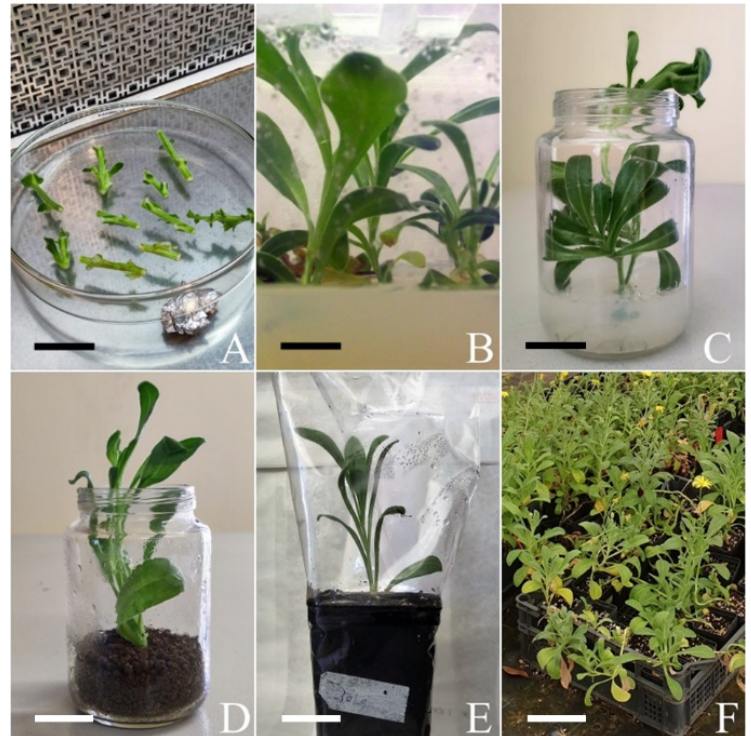
Figure 1. In vitro procedure for C. maritima plant regeneration from nodal explants. ( A ) Mono and binodal explants used for in vitro introduction (bar: 1 cm). ( B ) In vitro shoot regeneration obtained on MS medium after 30 days of culture (bar: 1 cm). ( C ) In vitro rooting obtained on MS medium after 30 days of culture (bar: 2.5 cm). ( D ) In vitro rooting obtained on Zeolite after 30 days of culture (bar: 2.5 cm). ( E ) Acclimatization phase (bar: 3.5 cm). ( F ) In vitro regenerated plantlets of C. maritima acclimatized in outdoor conditions after 30 days from transfer in outdoor conditions (bar: 7 cm).